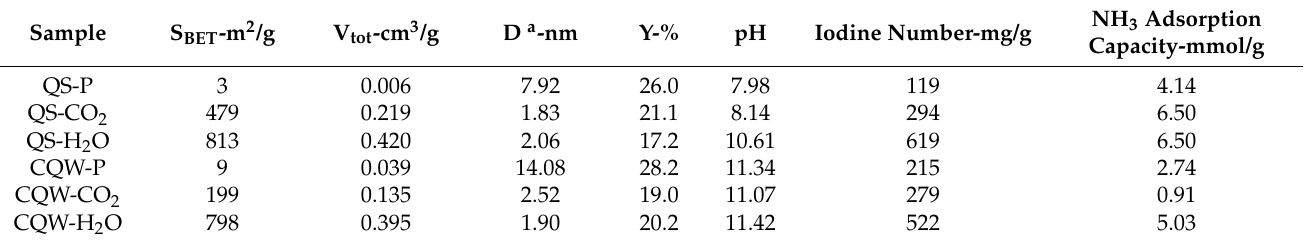
Table 3. Textural properties, yield, pH, and NH 3 adsorption capacity of pyrolytic and physical activated samples.